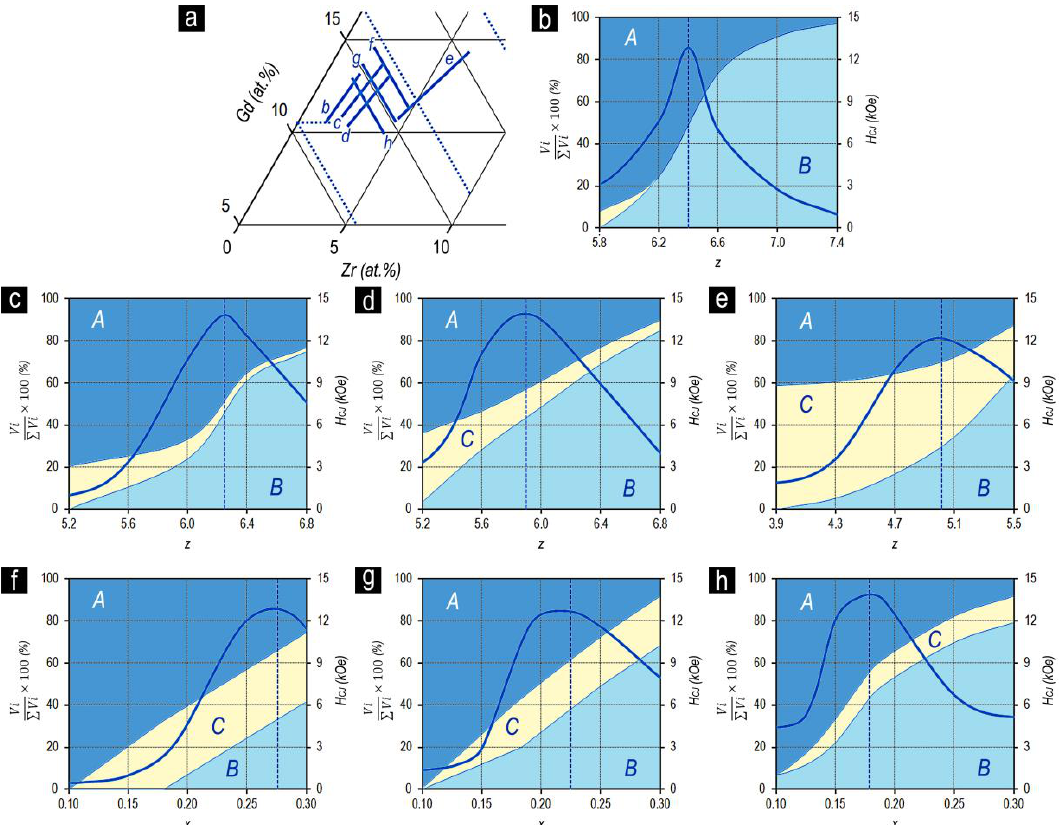
Figure 10. ( a ) Experimental series of Gd 1-X Zr X (Co 0.70 Cu 0.09 Fe 0.21 )z alloys in the section of the cobalt corner of the quasi-ternary (Co 0.70 Cu 0.09 Fe 0.21 )–Gd–Zr phase diagram and dependences of the volume percentage of structural components A, B, and C ((Vi / Σ Vi) × 100) and coercive force (H CJ ) on the chemical composition z for the alloys with x = 0.11 ( b ), 0.15 ( c ), 0.19 ( d ), and 0.30 ( e ) and on x for fixed z = 5.2 ( f ), 5.6 ( g ), and 6.0 ( h ). Based on the compilation of results available in Lyakhova et al. [11,12].